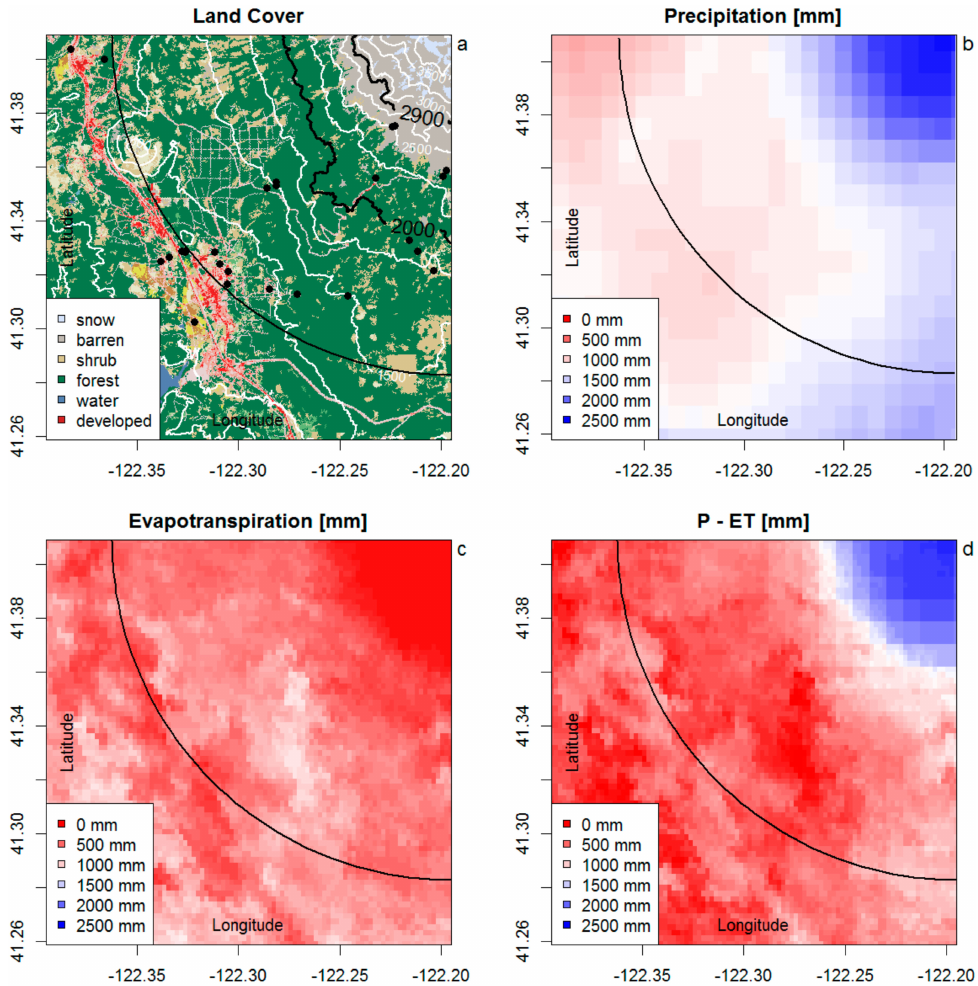
Figure 5. Land cover for selected spatial area, with well and spring locations (black symbols), 250 m elevation contours and the 14 km radius. The groundwater recharge elevation band indicated by the stable isotope and recharge temperature results is highlighted in ( a ) by black contours at 2000 m and 2900 m. Maps showing annual precipitation (P; ( b )), annual evapotranspiration (ET; ( c )) and annual precipitation excess (P − ET; ( d )), with a 14-km radius from the summit shown as a black line. Evapotranspiration based on MODIS NDVI ( c ) is higher at lower elevations but limited in range. Precipitation minus evapotranspiration shows a stark contrast between high elevation barren land and snow cover (above 2500 m) and lower elevation forest